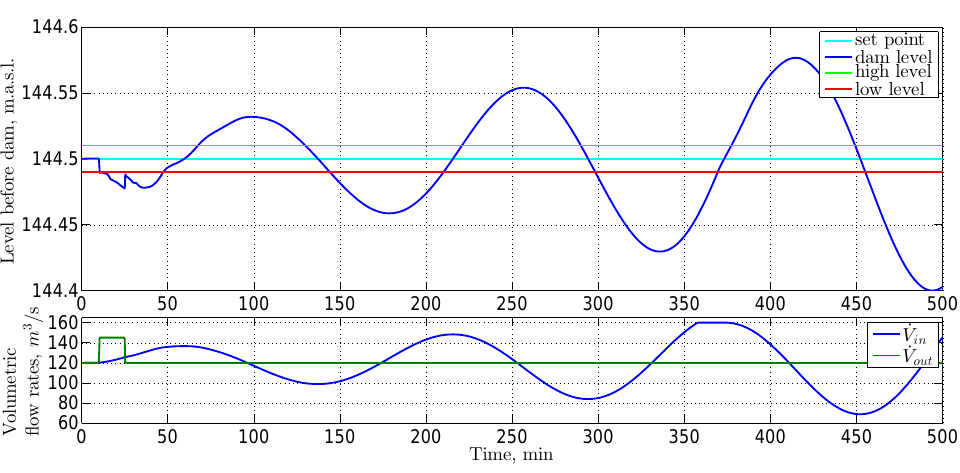
Figure 8: The results of long simulation with P controller ( T s = 5 and K p =